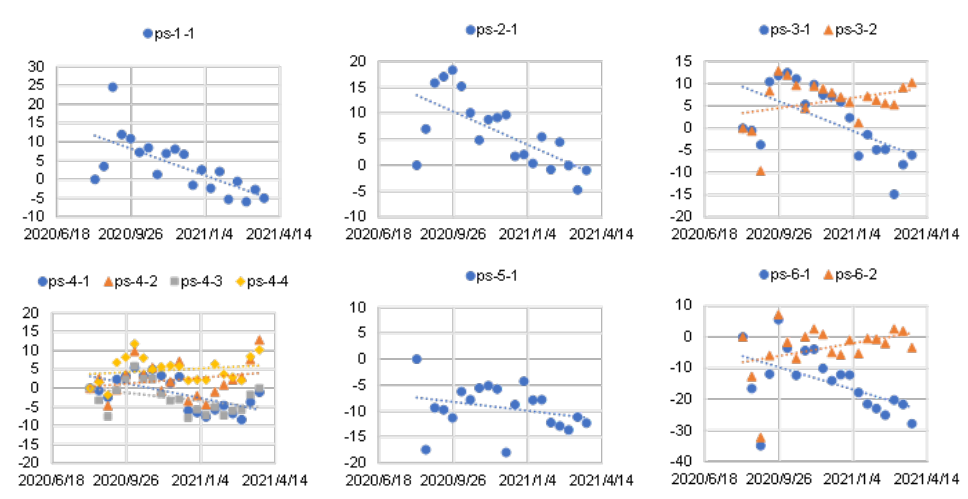
Figure 9. Time-series deformation for selected PS points.